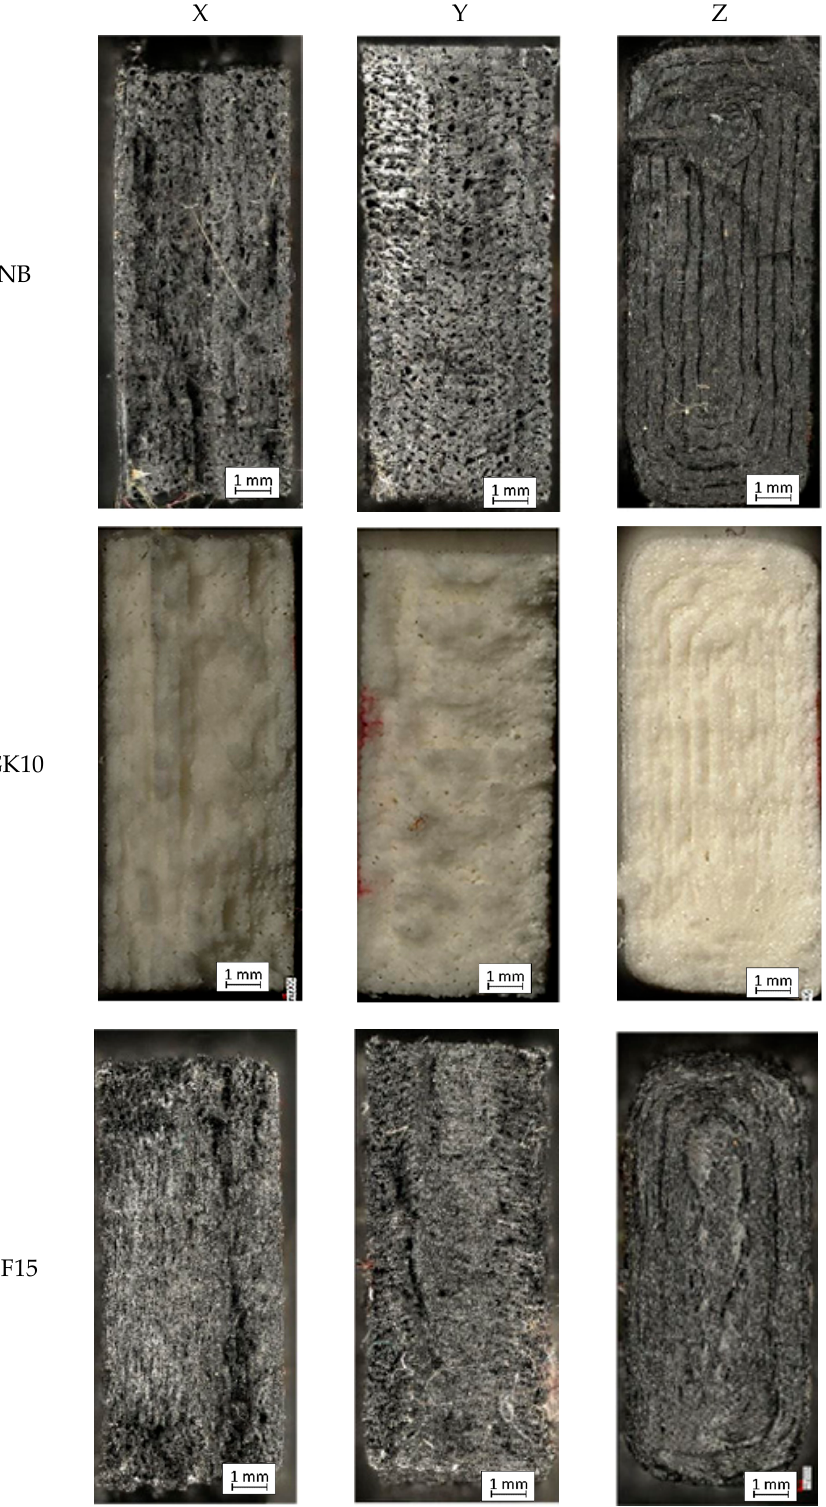
Figure 6. Fracture images of each sample.